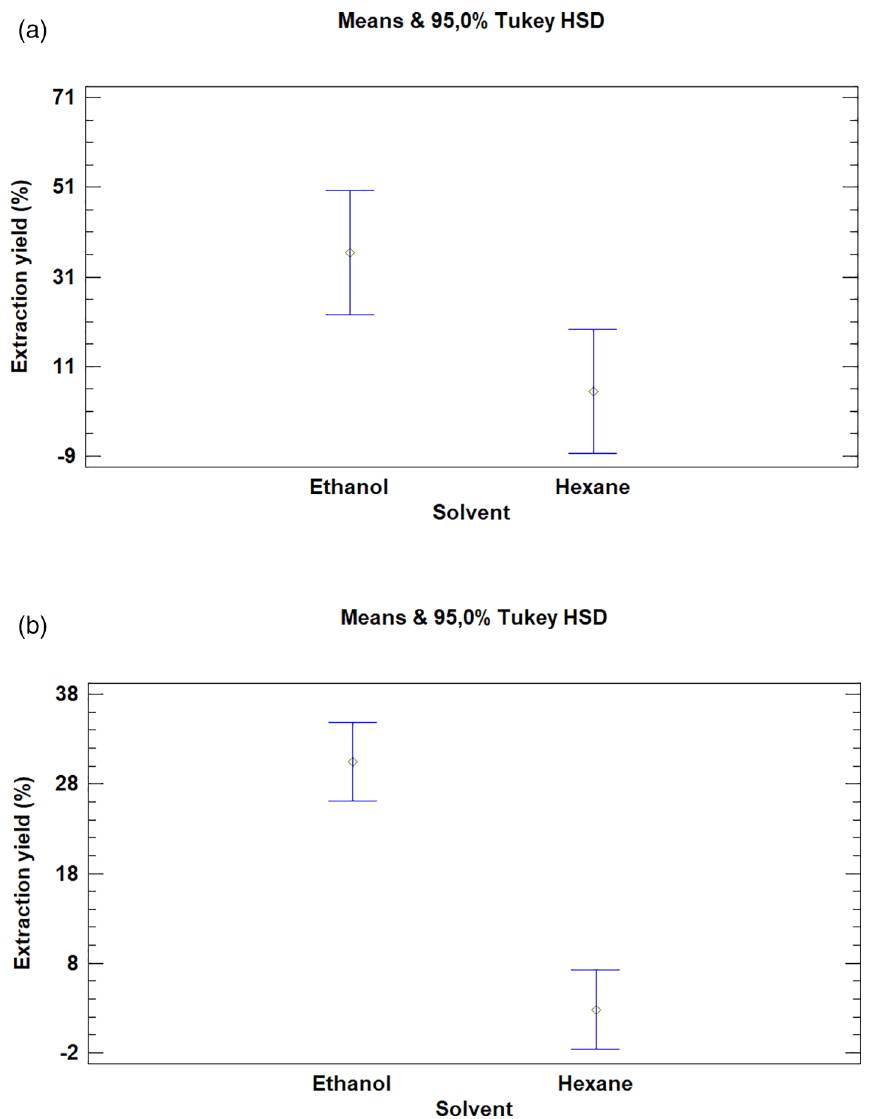
Figure8.ComparisonofTukeymeansforyieldsofextractsof Bidenspilosa L.and Crotonfloccosus accordingto